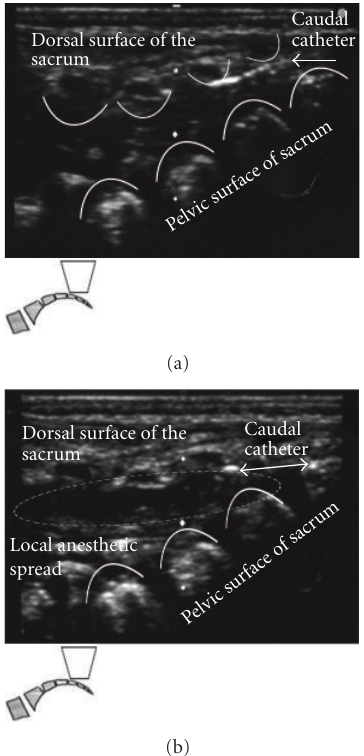
Figure 2: (a) Placing the probe longitudinally between the sacral cornua will capture the dorsal surface of the sacrum, the dorsal aspect of the pelvic surface of the sacrum, and the sacrococcygeal ligament. Angiocatheter penetrated the sacrococcygeal ligament and lies in the epidural space. (b) Local Anesthetic spread through Caudal Angiocatheter in caudal epidural space.